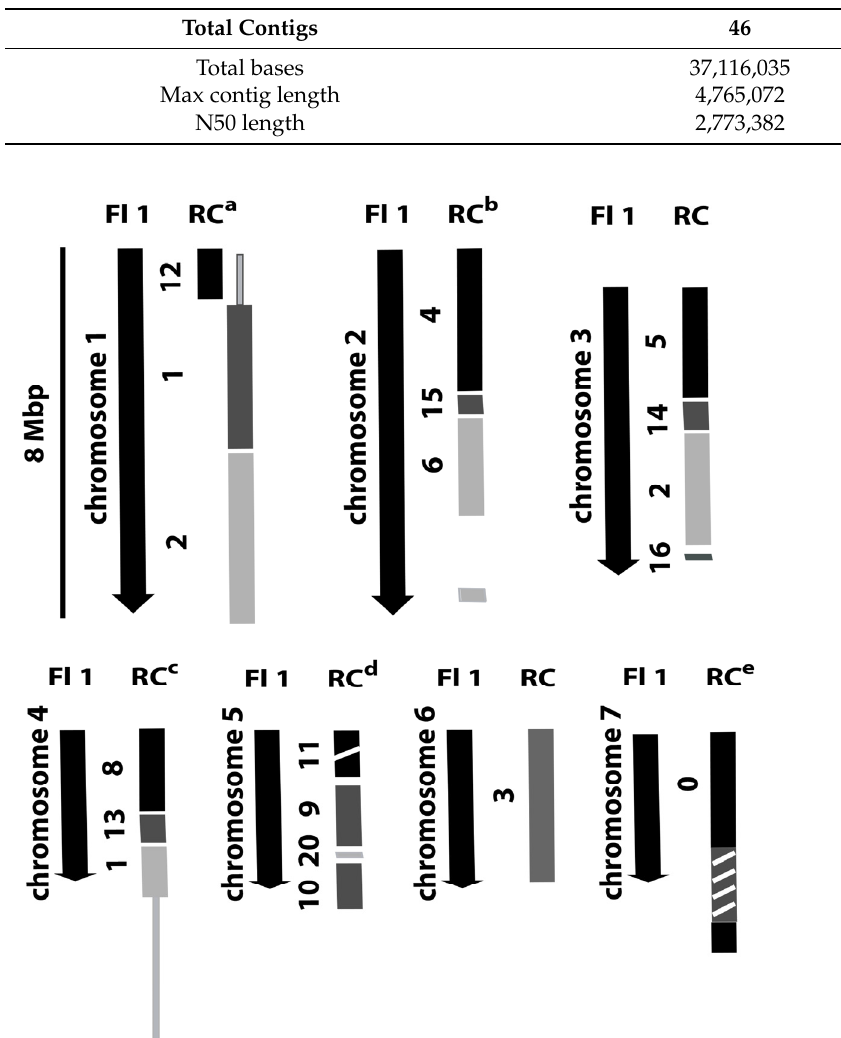
Figure 4. Diagram of relationships of the E. festucae Rose City (RC) isolate genome sequence contigs to the chromosomes of the E. festucae Fl1 isolate. a Line extending from RC contig 1 indicates region of contig 1 that is homologous to Fl1 chromosome 4. b Gap in RC contig 6 indicates the corresponding region of Fl1 that is found in RC contig 0. c Line extending from RC contig 1 indicates region of contig 1 that is homologous to Fl1 chromosome 1. d Break in RC contig 11 indicates an approximately 400,000 bp insert relative to Fl1 chromosome 5. e Hashed box in RC contig 0 indicates region of contig homologous to Fl1 chromosome 2.